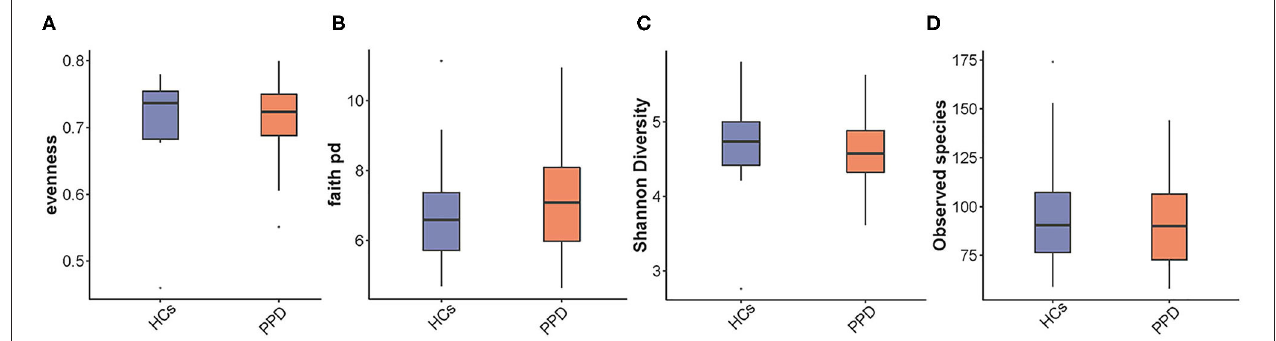
FIGURE 2 | An analysis of microbial α -diversity. Evenness index (A) ; Faith pd index (B) ; Shannon diversity (C) ; Observed species (D) .